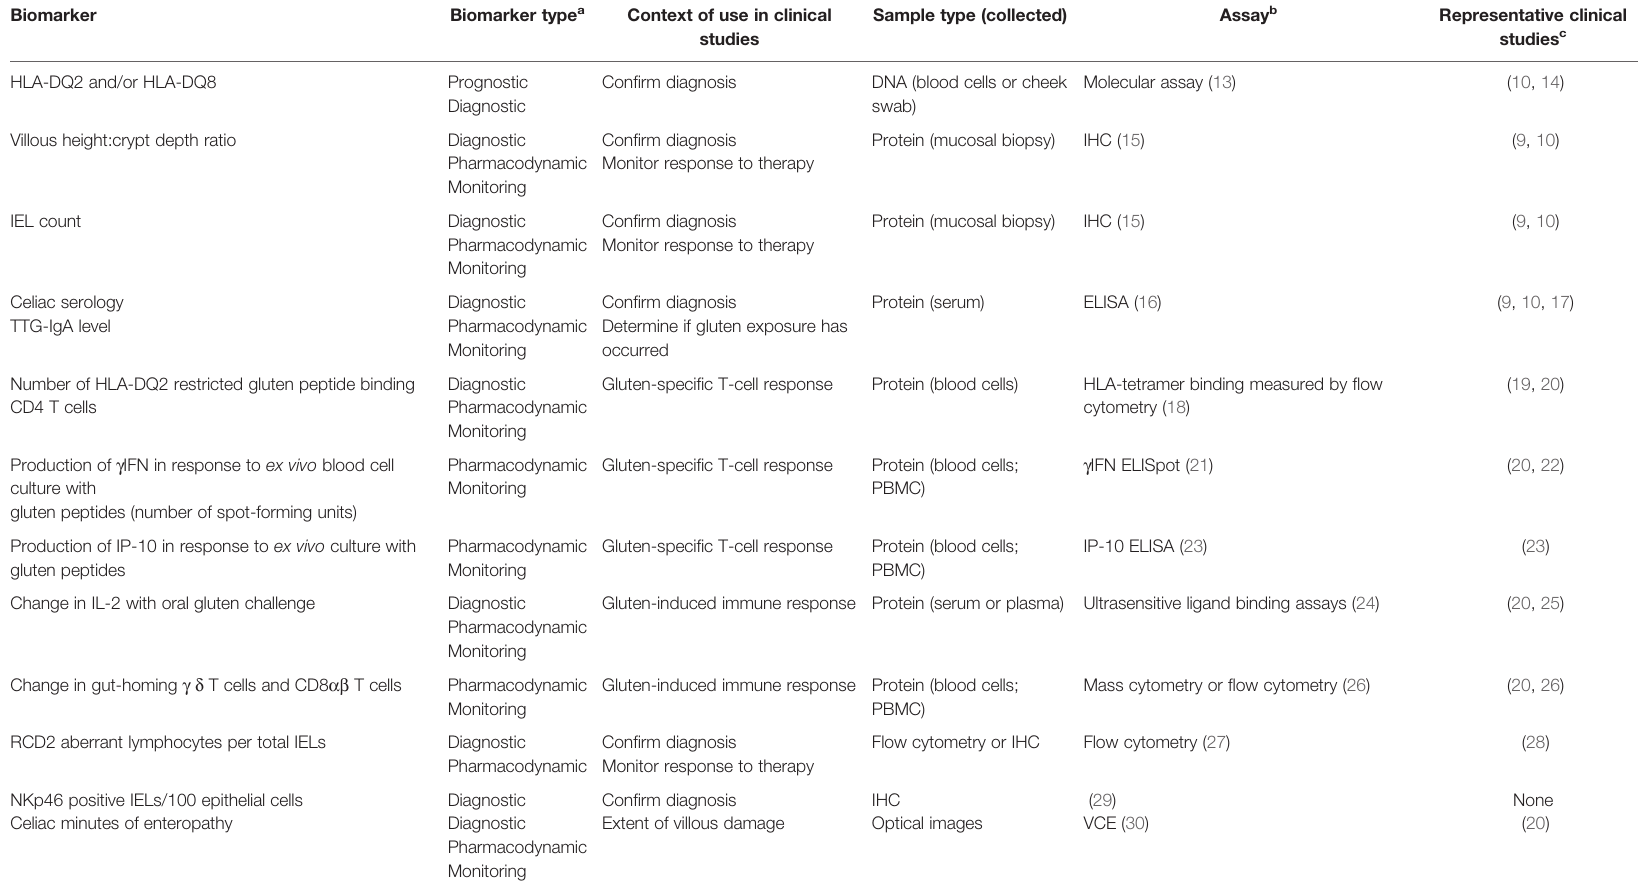
TABLE 1 | Biomarkers used in celiac